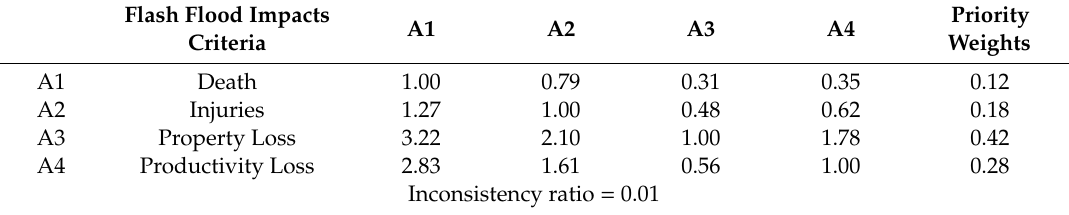
Table 4. Judgment matrix on the preferences of flash flood impacts